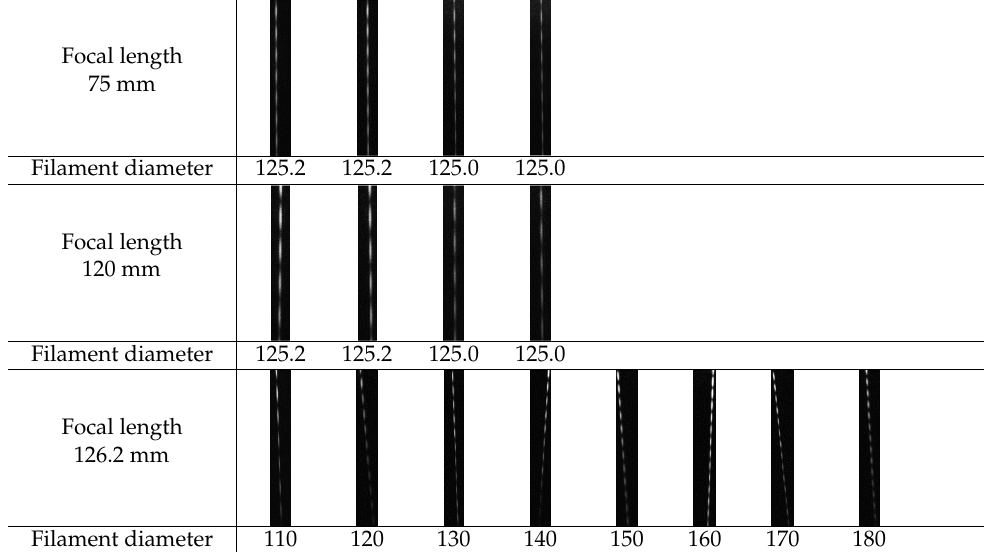
Table 1. Diffraction images of different filaments * (unit: µ m).